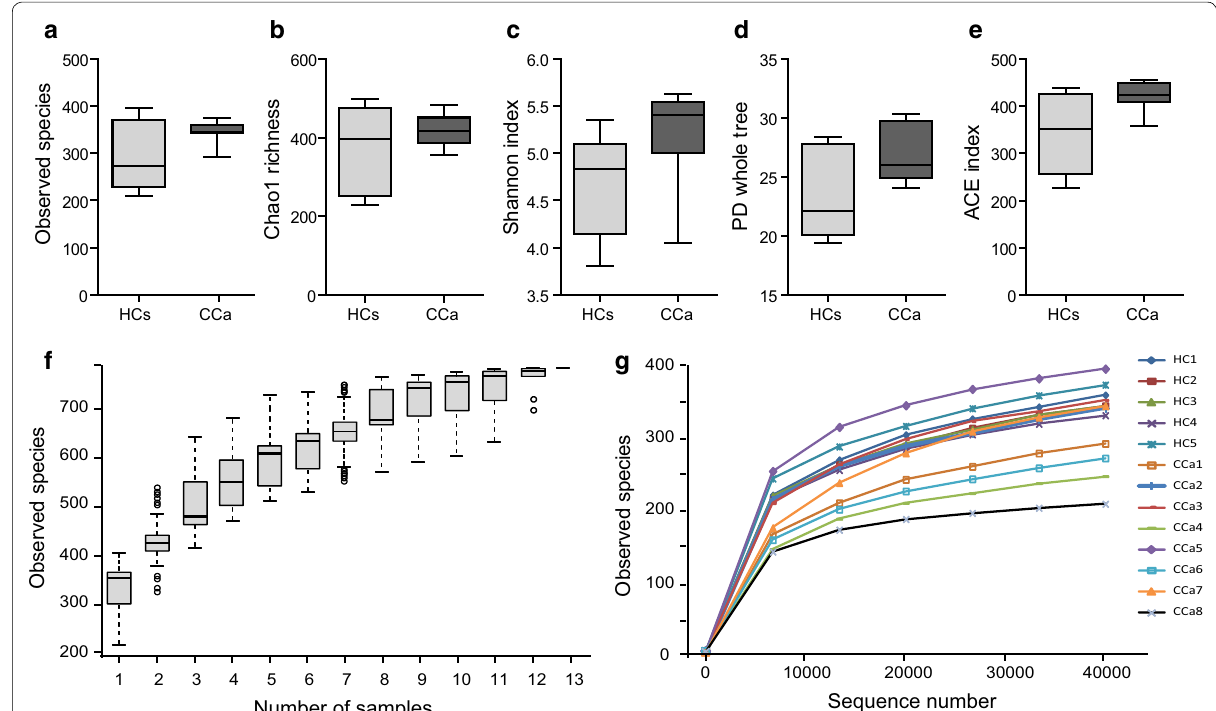
Fig. 1 Analysis of alpha diversity in patient with cervical cancer compared with healthy controls. a Observed species, b Chao1 richness index, c Shannon index, d PD whole tree, e ACE index, f species accumulation curves, g rarefaction curves. Patient with cervical cancer (CCa), healthy controls